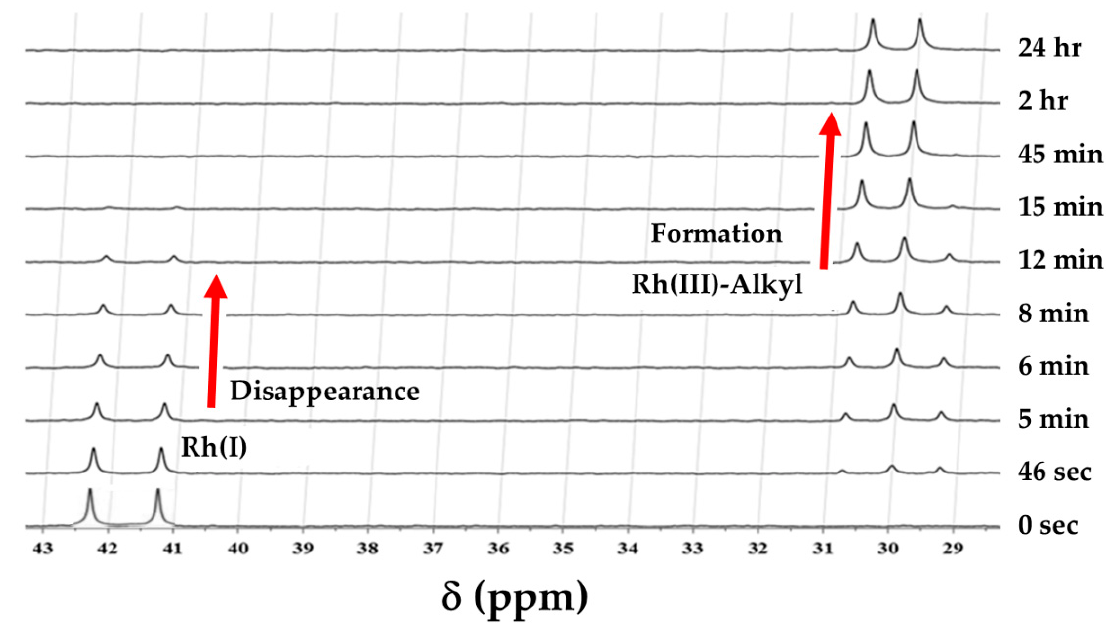
Figure 3. Successive 31 P NMR spectra illustrating the oxidative addition of iodomethane to [Rh(Indoli)(CO)(PPh 3 )] ( A2 ) in dichloromethane at 25 ◦ C. [Rh] = 0.02 M and [MeI] = 1.0 M. A minor Rh(III)- alkyl isomer (doublet at 29.5 ppm) is observed, which disappears after ca. 15 min, never exceeds ca 5–10% of the major isomer, and does not noticeably contribute to the reaction; thus, it has been ignored further in this study. Total time = 24 h.